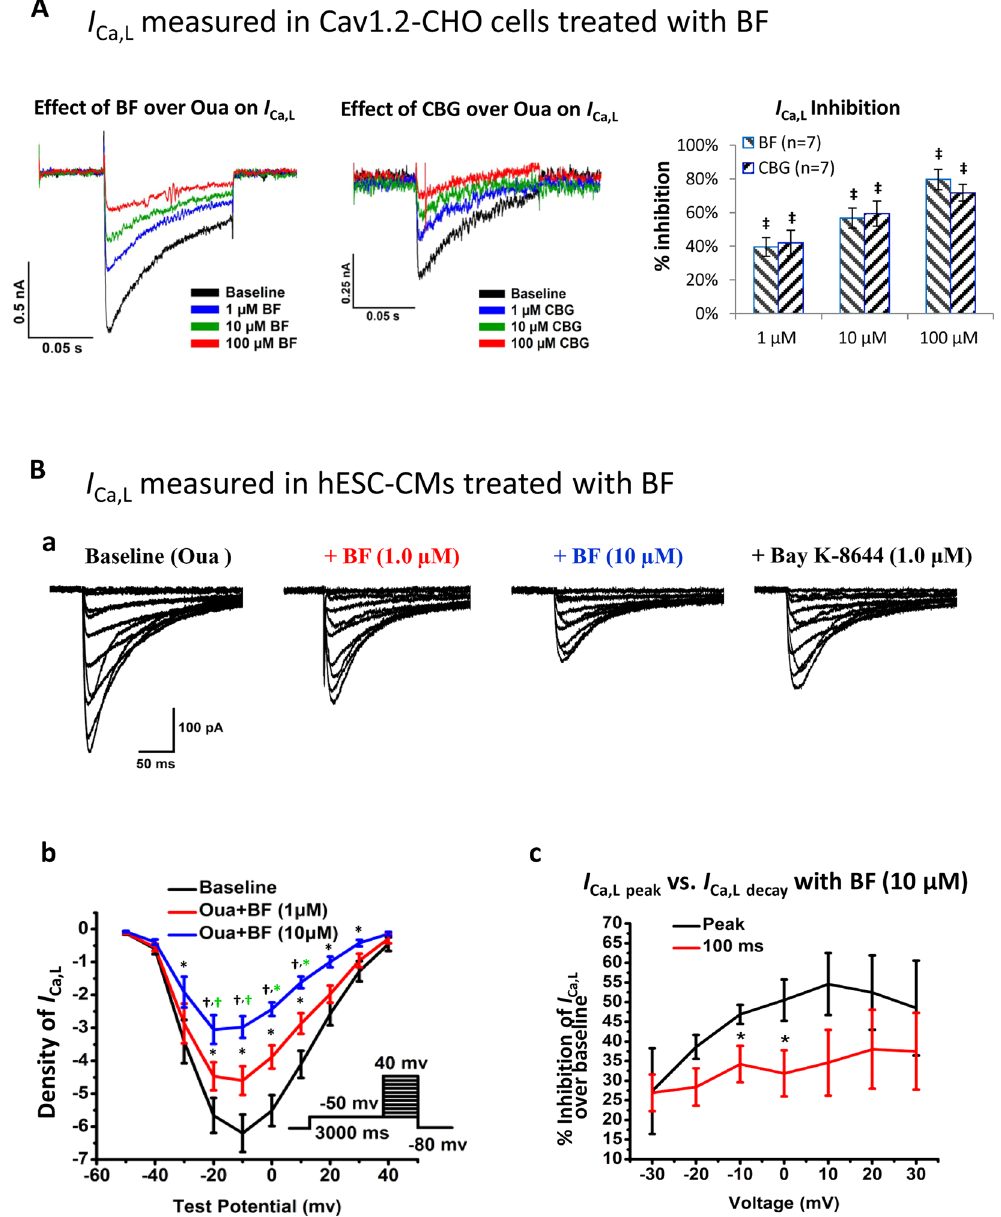
Figure 3. NKA inhibition-independent effects of BF on I Ca,L in Cav1.2-CHO and hESC-CMs. ( A ) Effects of BF and CBG on I Ca,L recorded in Cav1.2-CHO cells pre-incubated with 10 µ M of Oua and with extracellular KCl replaced by CsCl to further suppress the NKA activity. Shown on the left and middle respectively are representative traces showing the effects of BF and CBG on I Ca,L recorded by Patchliner ® . Shown on the right is the % inhibition plotted in bar-graph. ‡ p < 0.001, vs. baseline (One-Way ANOVA). Data are presented as mean ± SEM. ( B ) Effect of BF on I Ca,L in hESC-CMs with NKA fully blocked by Oua (recorded by conventional voltage-clamping). (a) Representative traces of the voltage-gated I Ca,L recorded from a hESC-CM at baseline (with 10 µ M Oua incubation for 10 minutes), with subsequently treated with 1.0 and 10 µ M of BF for 5 minutes, and finally with Bay K8644 (1 µ M) treatment. (b) I-V curves showing the voltage-dependent I Ca,L current densities (pA/pF). * p < 0.05, † p < 0.01, vs. baseline (One-Way ANOVA); * (green) p < 0.05, †(green) p < 0.01, vs. 1.0 µ M BF (One-Way ANOVA). n = 7. (c) Comparison of the I Ca,L current densities at peak ( I Ca,L peak ) and during decay ( I Ca,L decay ) recorded from cells treated with BF (10 µ M). Data presented are % inhibition over baseline levels of I Ca,L at peak and at 100 ms during current decay. n =